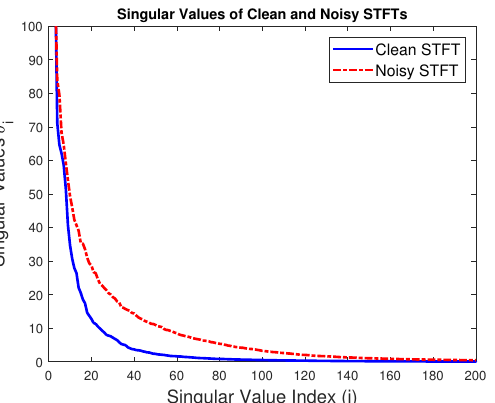
Figure 2. The initial 200 singular values corresponding to the STFTs of clean (in solid blue) and noisy (in dash-dotted red) signals.